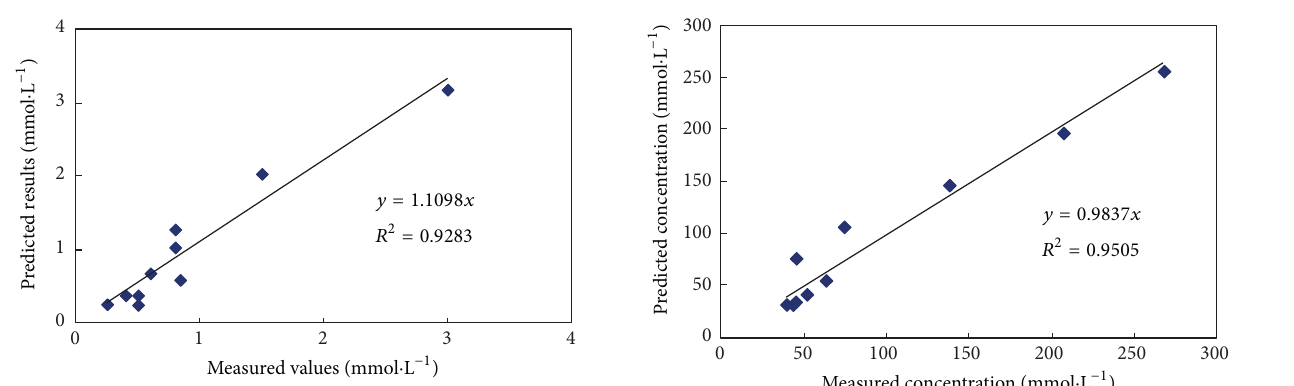
Figure 7: Regression analysis of the measured values and predicted results for the Na + concentration of the soil leachate in a penetration